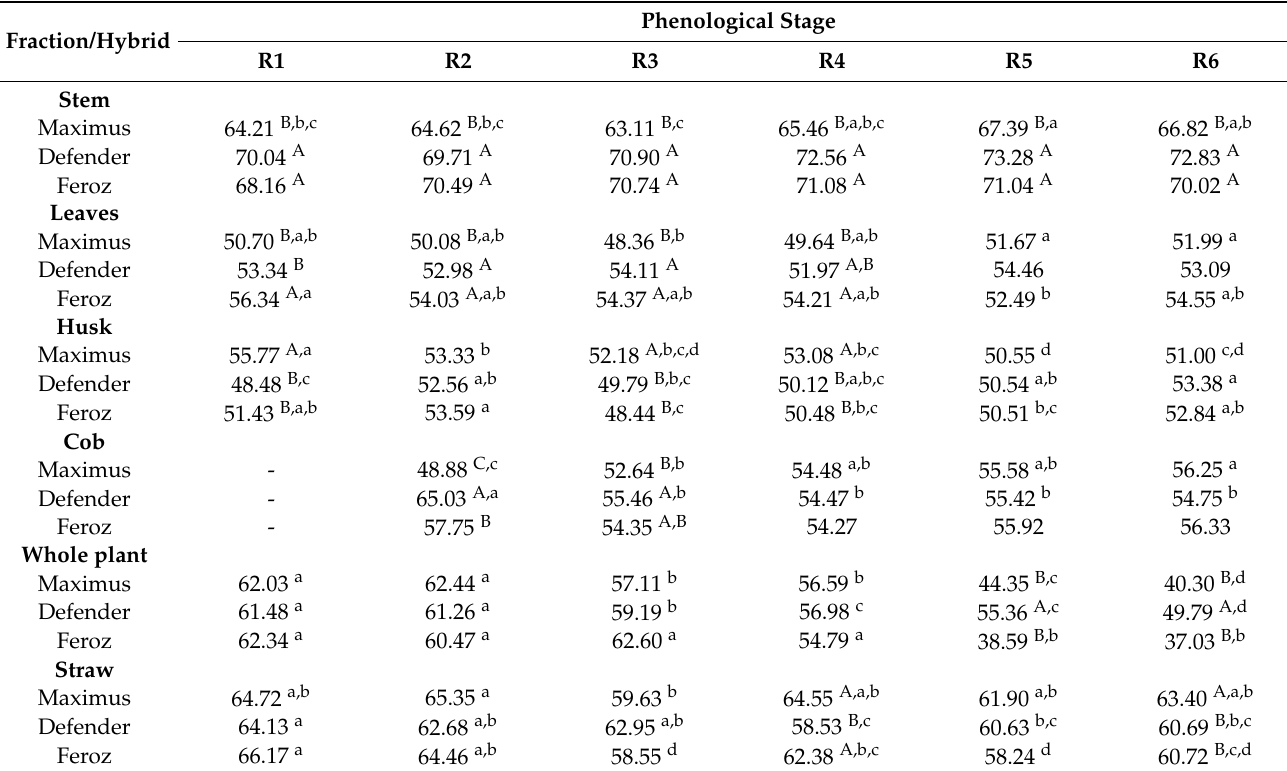
Table 6. Hemicellulose (% of NDF) of the whole plant and the fractions of three maize hybrids harvested at the beginning of the six reproductive stages of maturity.